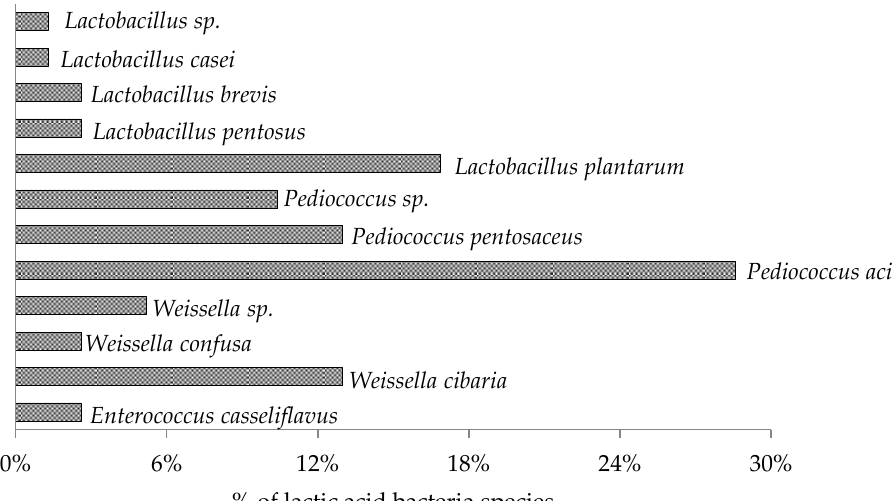
Figure 1. Frequency of lactic acid bacteria genera isolated from alfalfa silage through the fermentation period (56 days).